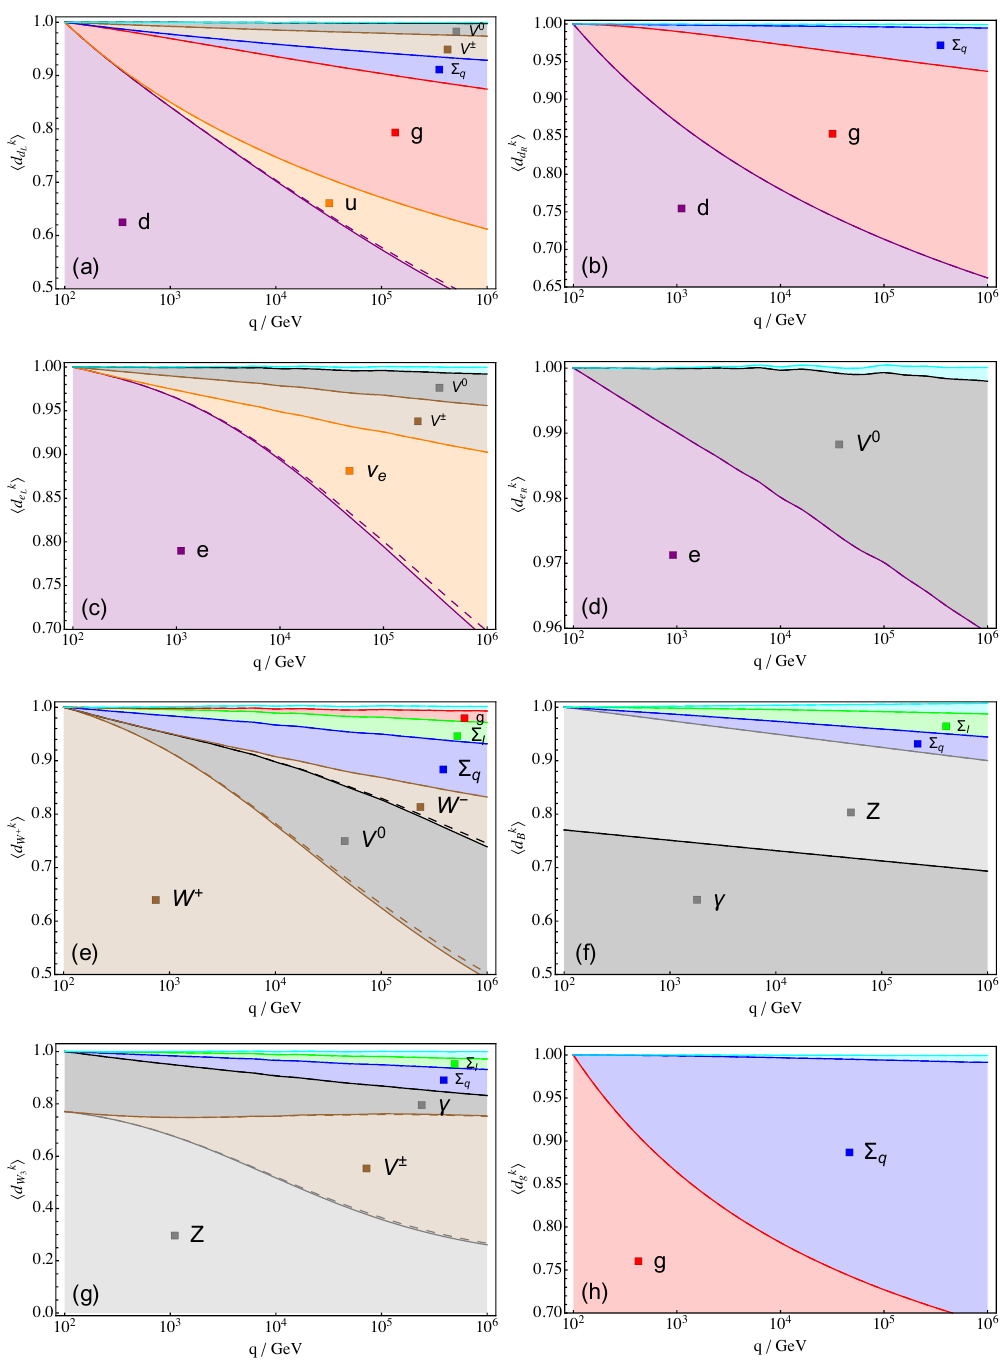
Figure 1 . The momentum averaged fragmentation functions h d k (e,f) W + ; B , (g,h) W 3 ; g . The di(cid:11)erent values of k are stacked on top of each other, such that the total equals one, as demanded by the sum rule. Dashed/solid lines show DL/NLL resummed results.